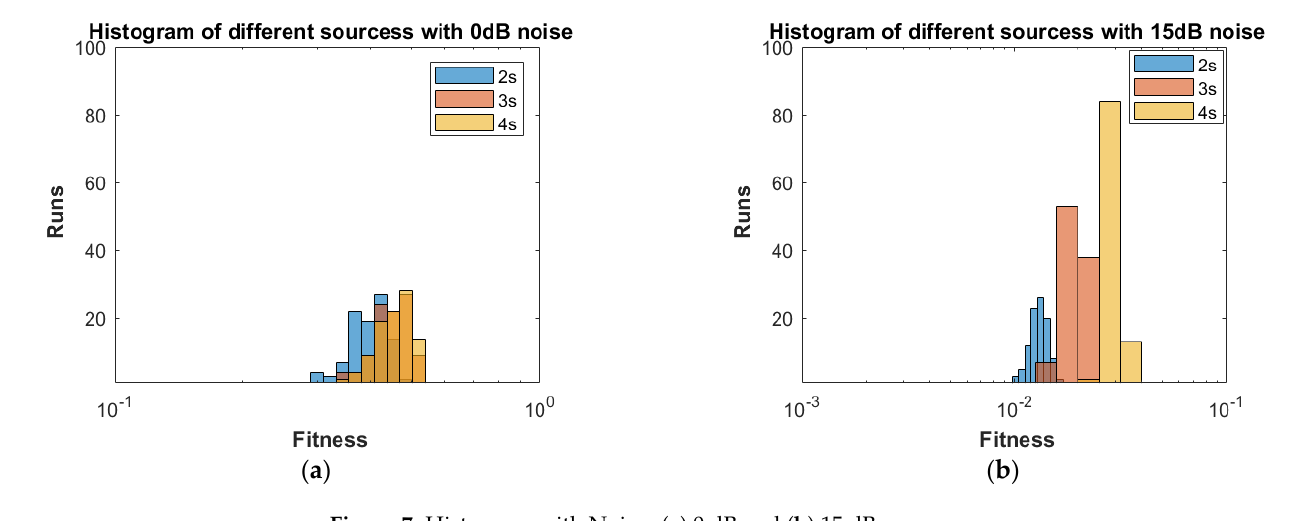
Figure 6. Box Plot with Noises ( a ) 0 dB and ( b ) 15 dB.